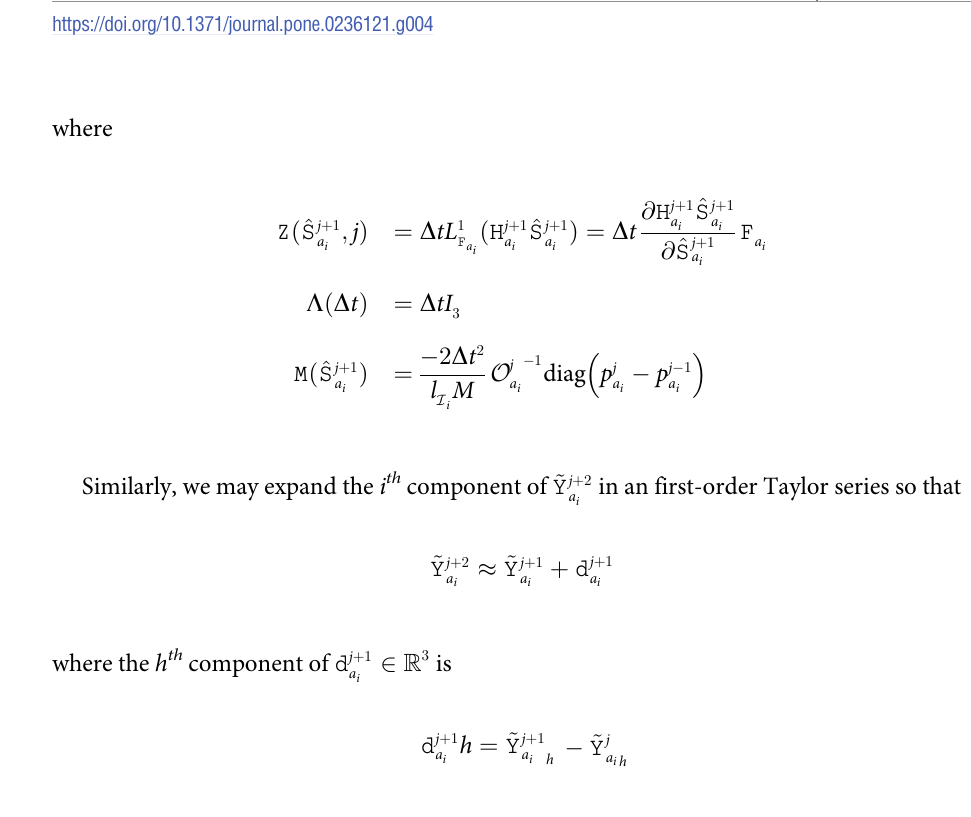
coupled with the node a ’s model. The filter employs the i i a i